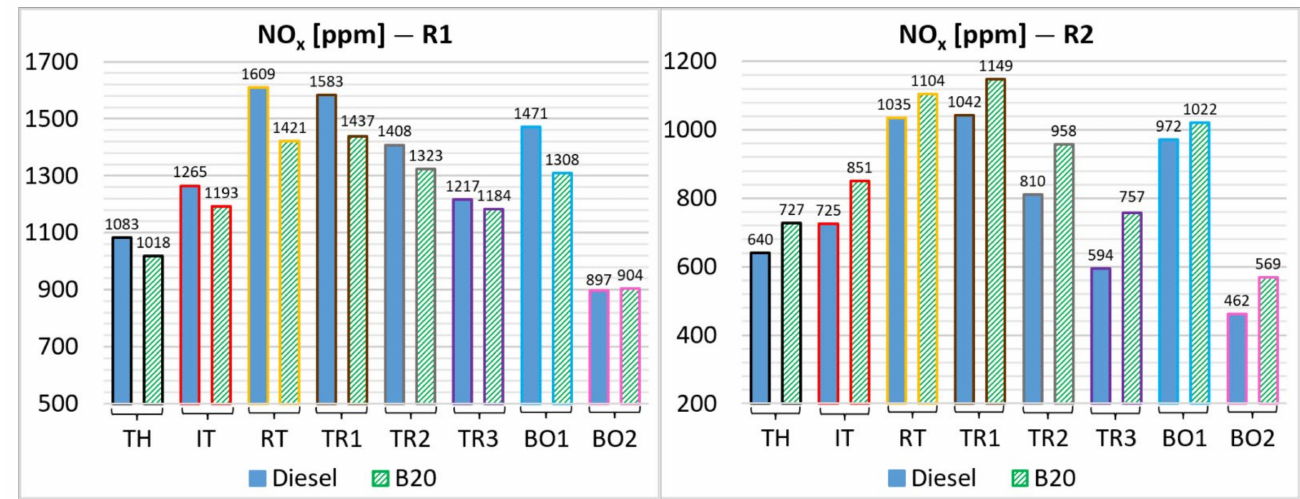
Figure 13. Nitrogen oxides (NO x ) variation by different shapes of